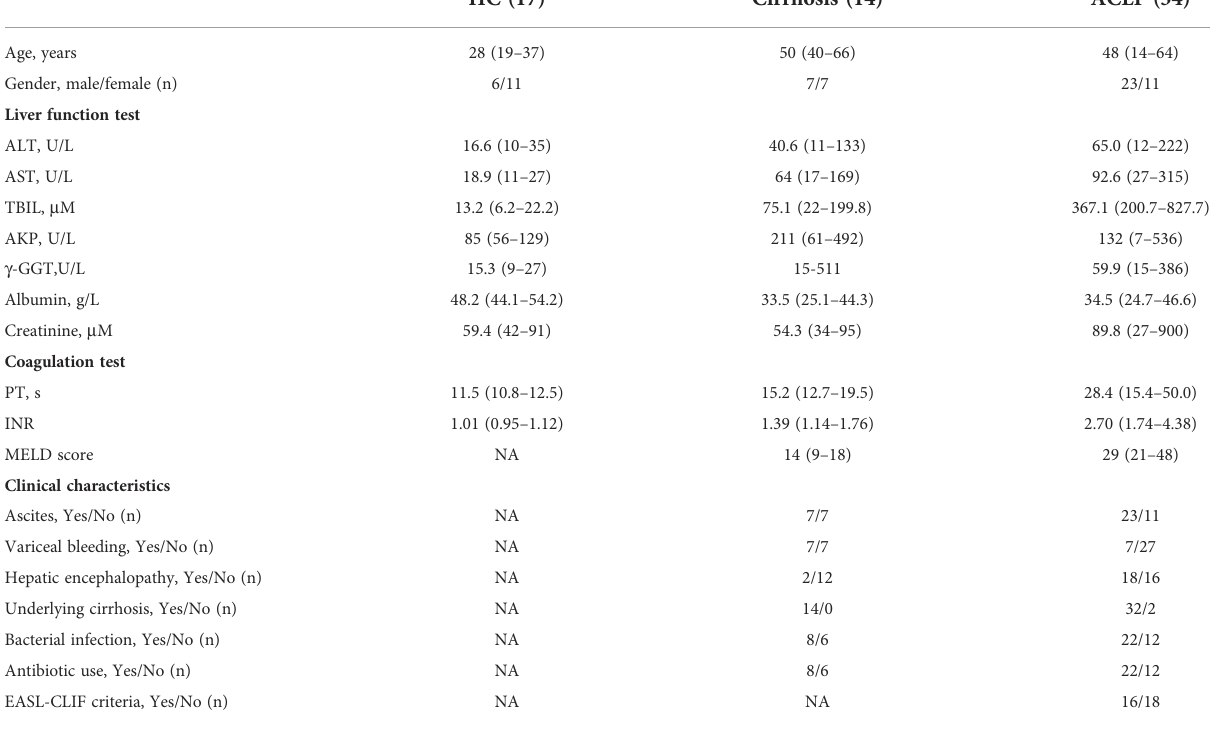
TABLE 1 The demographic and clinical characteristics of